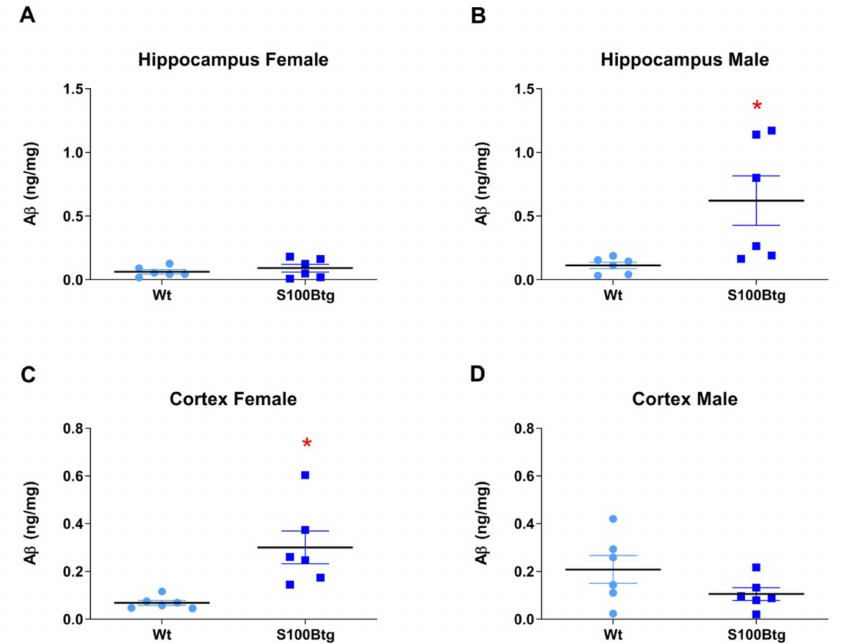
Figure 3. Brain levels of amyloid β -peptide 1-42 (A β 42 ) in one-year-old S100Btg and wt mice. A β 42 levels were quantified in ( A , B ) hippocampus and ( C , D ) cortex; measurements were performed by ELISA. Data are expressed as means ± SE (7 mice/group). * indicates a statistically significant difference (Student’s t -test, assuming p < 0.05).